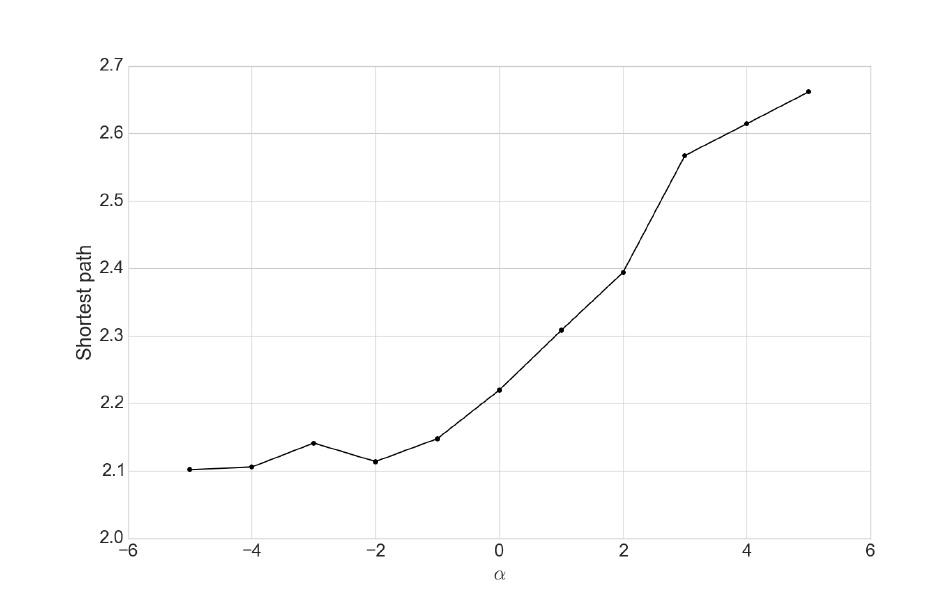
Figure 10. Risk preference α vs. the network shortest